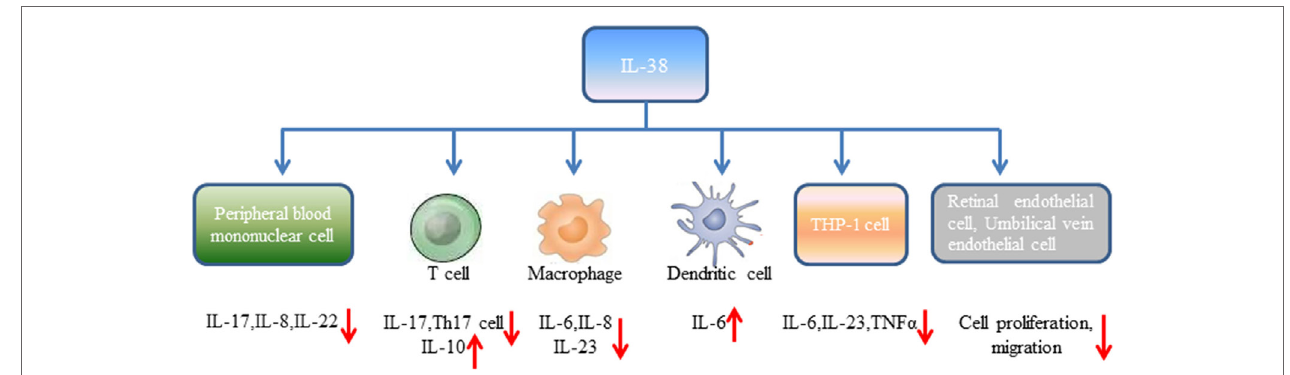
FigURe 1 | Biological effects of interleukin-38 on distinct cell